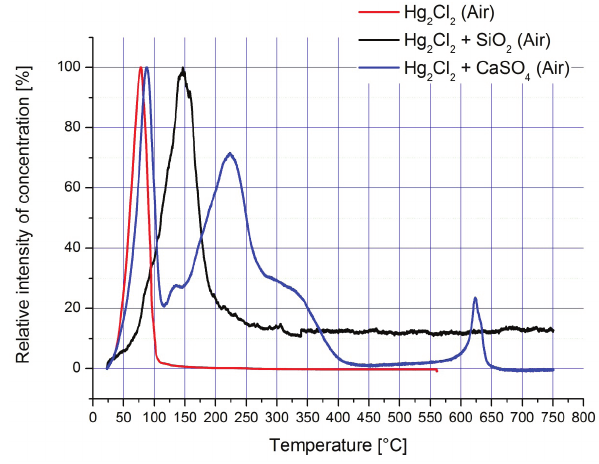
Cl , purged with 2 2